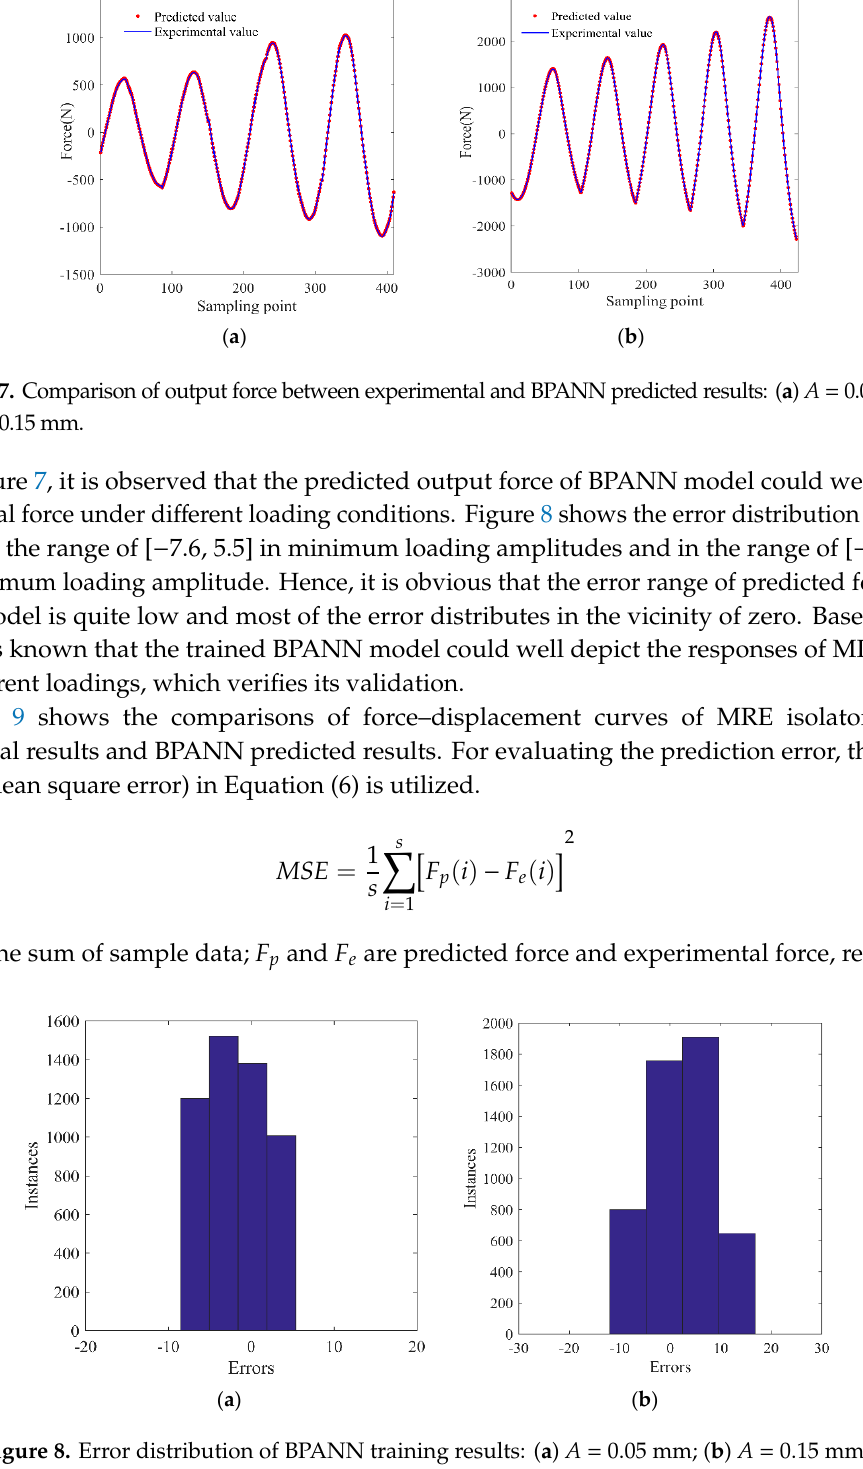
Figure 8. Error distribution of BPANN training results: ( a ) A = 0.05 mm; ( b ) A = 0.15